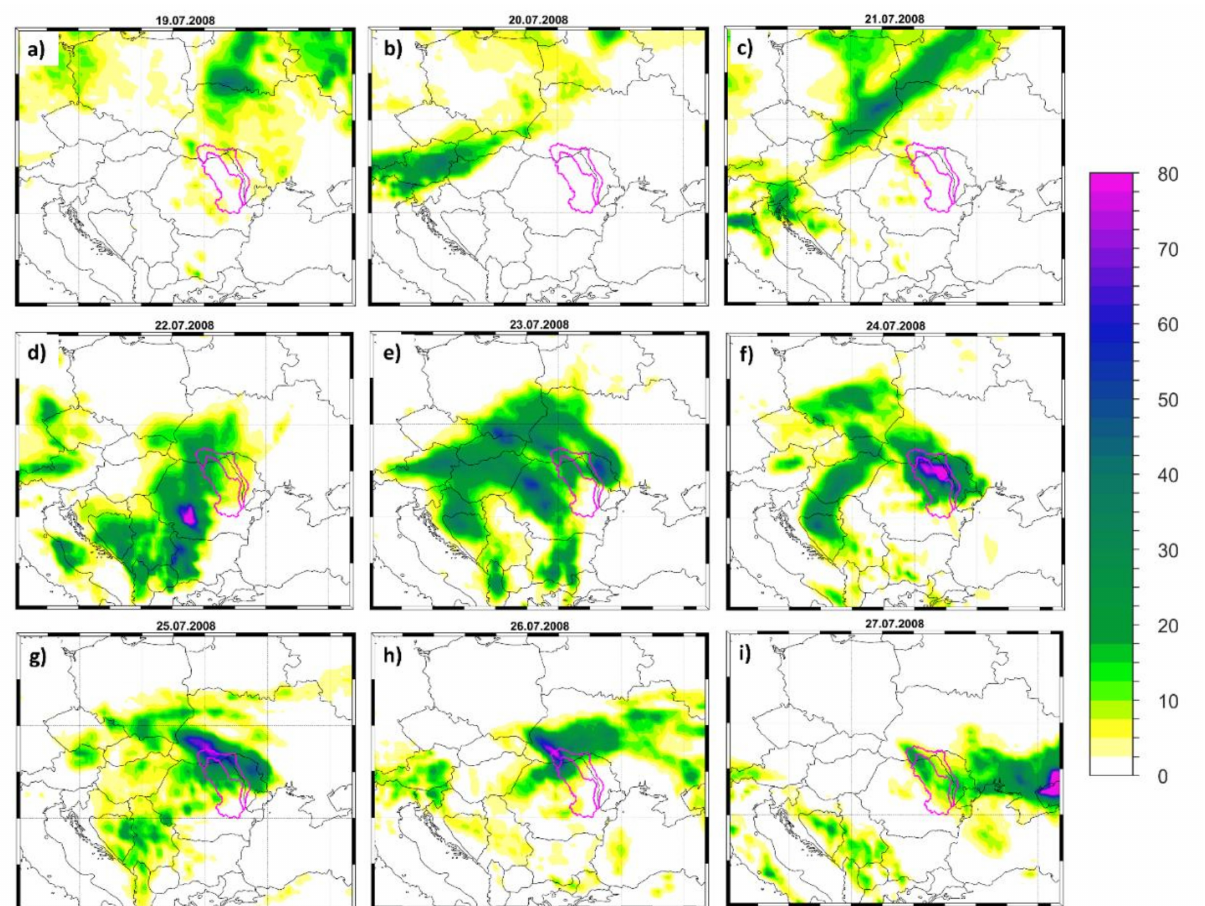
Figure 2. Daily precipitation totals (PP) for: ( a ) 19 July 2008; ( b ) 20 July 2008; ( c ) 21 July 2008; ( d ) 22 July 2008; ( e ) 23 July 2008; ( f ) 24 July 2008; ( g ) 25 July 2008; ( h ) 26 July 2008, and ( i ) 27 July 2008. Units: PP